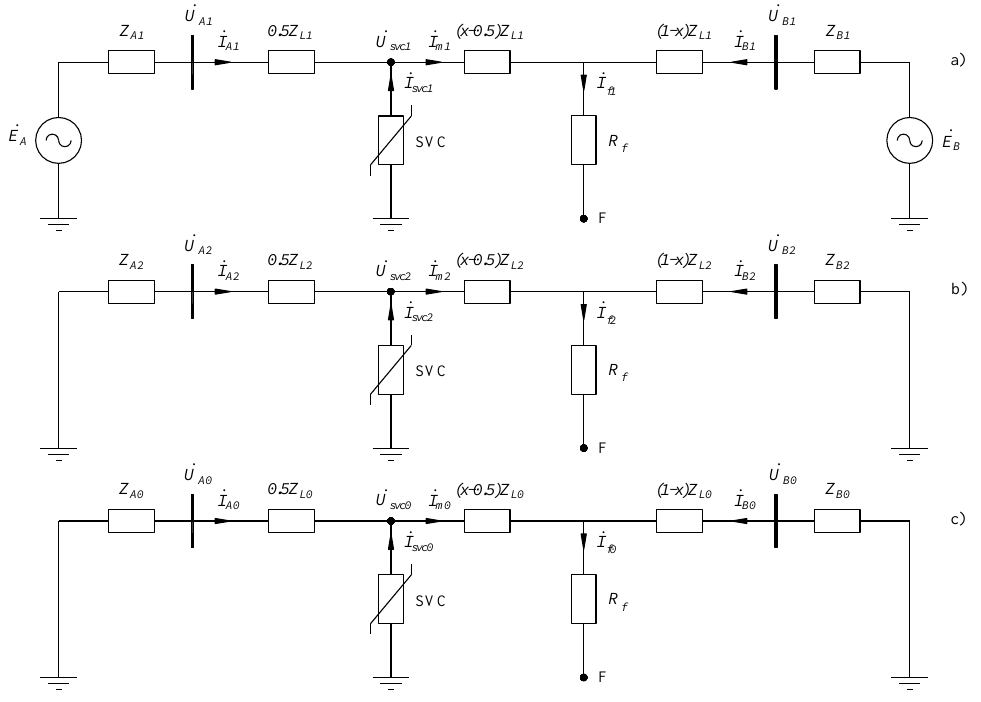
Figure 4. The sequence networks. ( a ) the positive sequence network; ( b ) the negative sequence network; ( c ) the zero sequence